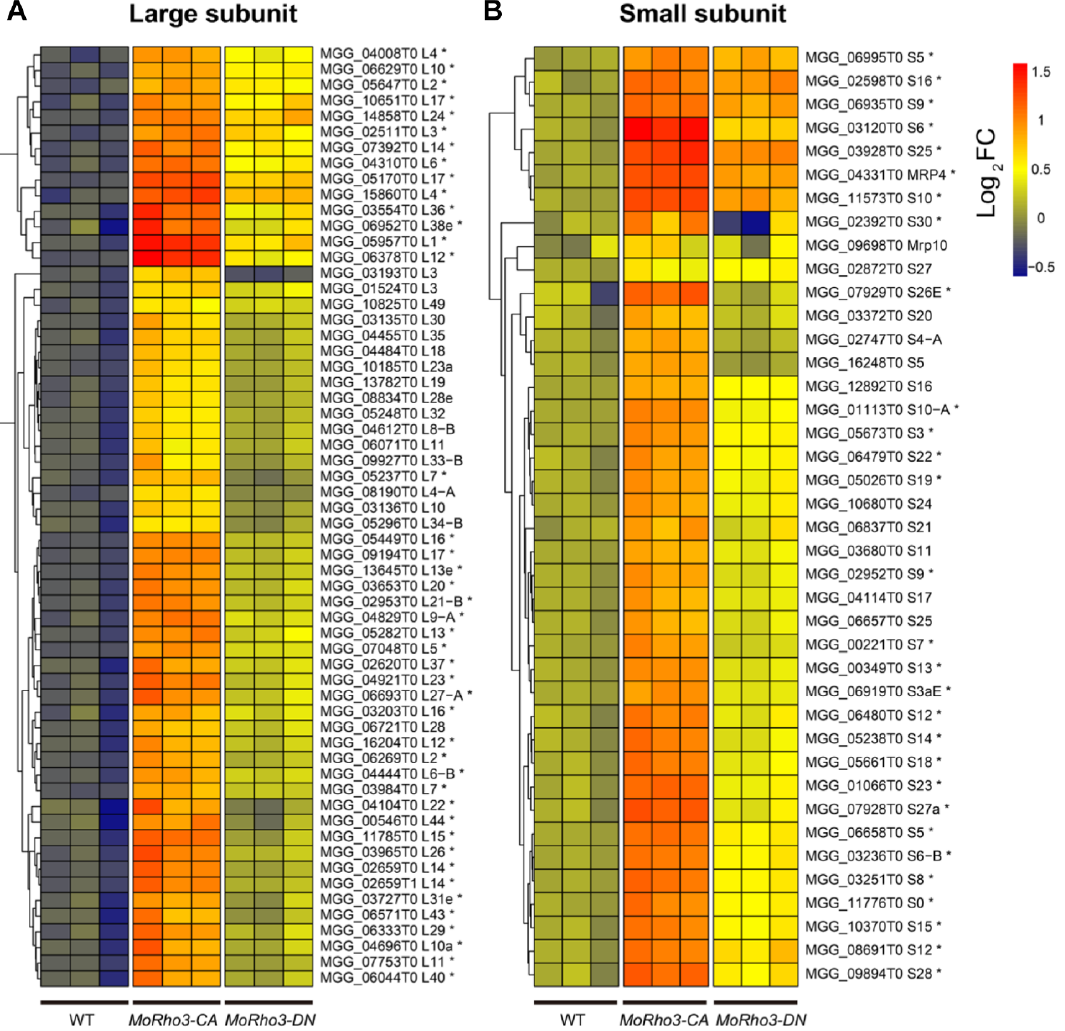
Figure 4. CA mutation enhances the expression of ribosome biogenesis genes. ( A ) Expression heatmap of genes related to ribosomal large subunit. ( B ) Expression heatmap of genes related to ribosomal small ( B ) subunit. * stands for differential expressed gene.